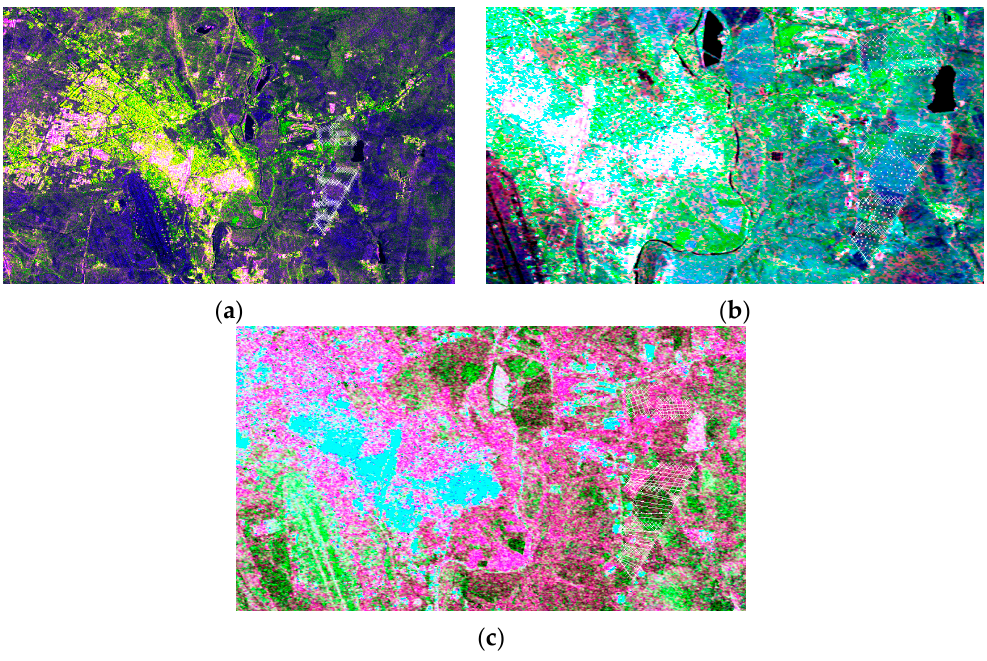
Figure 5. The resulting Radarsat-2 data from 27 February 2015 after ( a ) standard sigma backscattering technique; ( b ) Freeman–Durden; and ( c ) H/A/ α models.